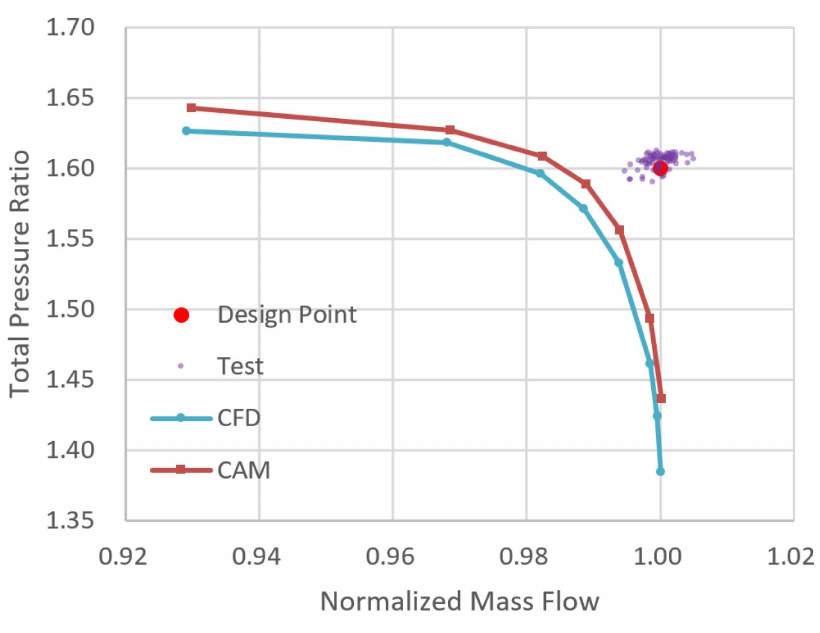
Figure 11. Total pressure ratio vs. inlet normalized flow.